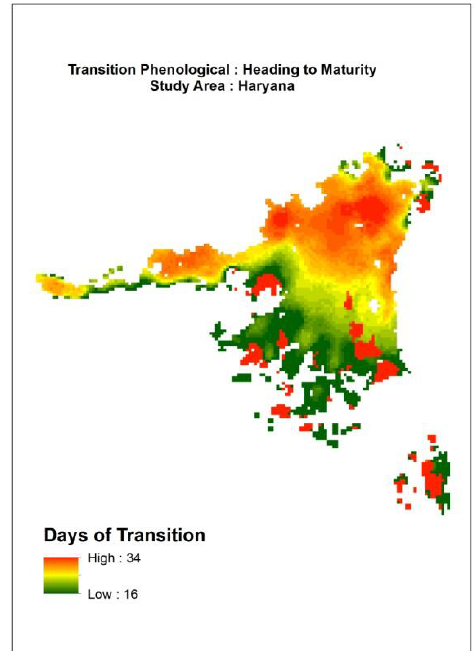
Figure 14: Transition days from Heading to Maturity for Haryana